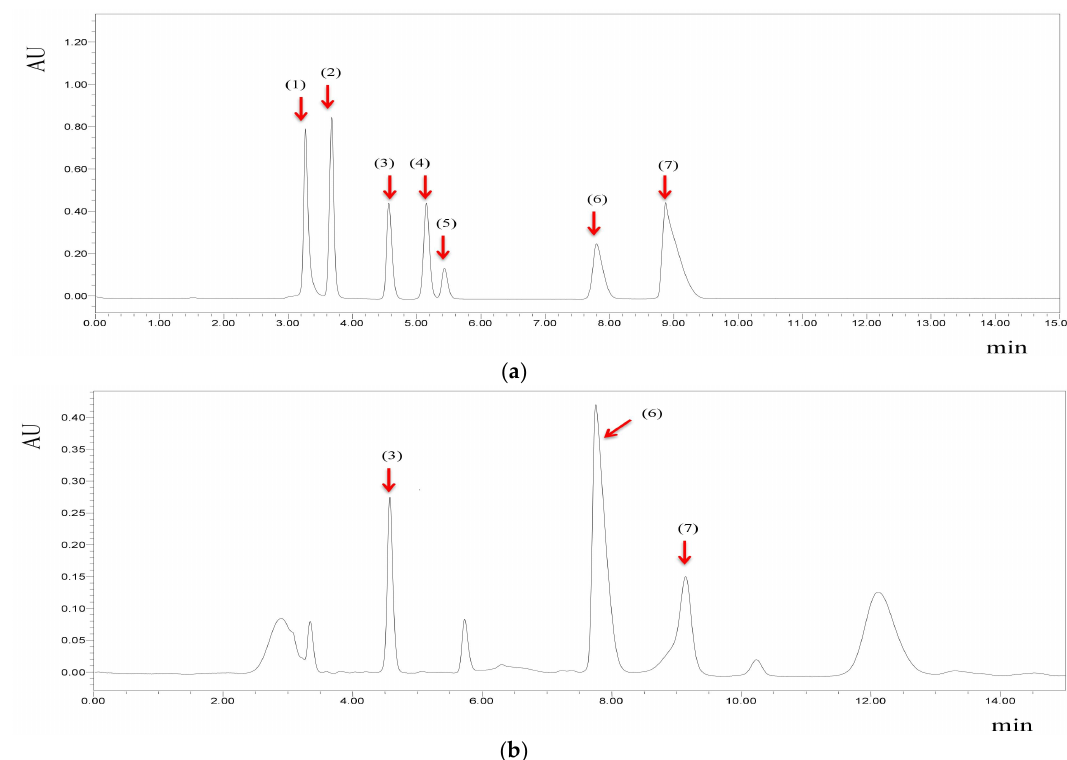
Figure 2. The chromatograms of the organic acid standards ( a ) and apple vinegar (Cu Bo Shi) ( b ) under 210 nm. Peak identification and retention time: (1) oxalic acid, 3.268 min; (2) tartaric acid, 3.677 min; (3) malic acid, 4.565 min; (4) ascorbic acid, 5.150 min; (5) lactic acid, 5.429 min; (6) citric acid, 7.795 min; (7) succinic acid, 8.869 min.